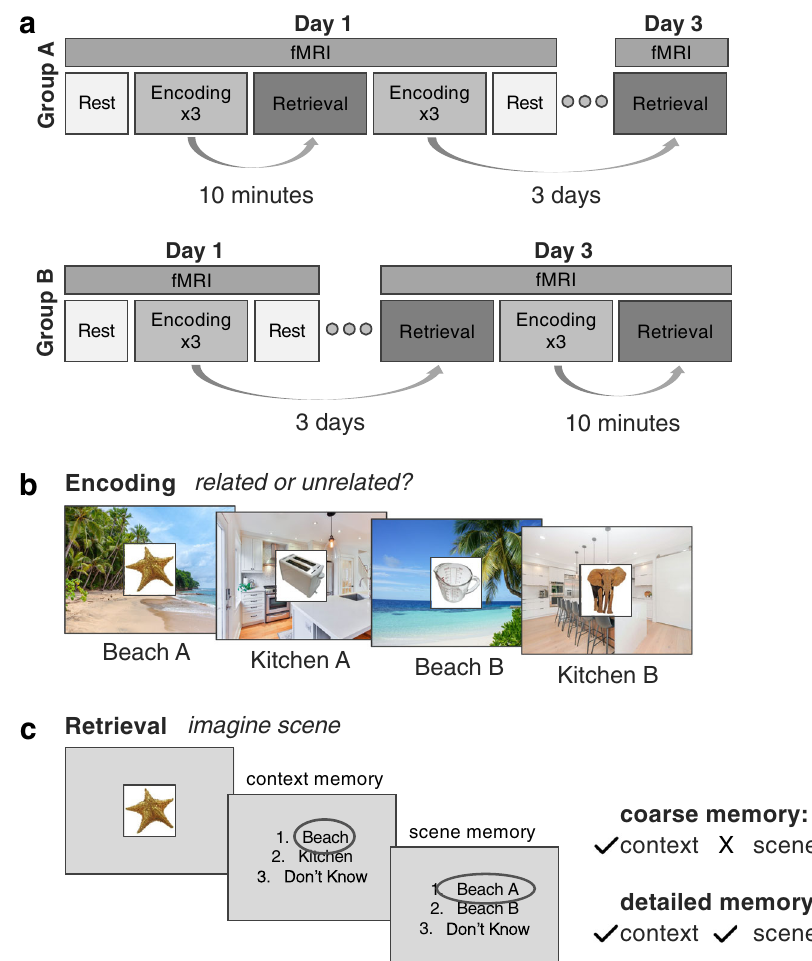
Fig. 1 | Experimental design. a Participants underwent encoding and retrieval sessions across a short delay of 10min and a long delay of 3 days in the fMRI scanner. Participants were counterbalanced across delays according to the depicted structure. Encoding fMRI data was not analyzed for the present experiment. b During encoding participants viewed a series of objects, each paired with one of four repeating scenes (two beaches/two kitchens) and indi- cated whether the object was related to the background scene. Participants did not view the names of the scenes during encoding, rather, they learned the names of the scenes and practiced visualizing them in detail prior to beginning the experiment. c During retrieval participants were asked to imagine the